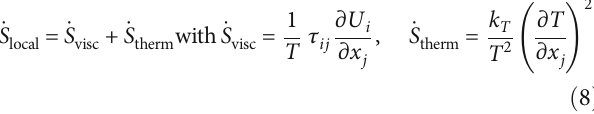
Figure 24: Comparison of local losses due to viscous and heat-transfer e ff ects ( Ma entropy generation rate; (c) local Bejan number